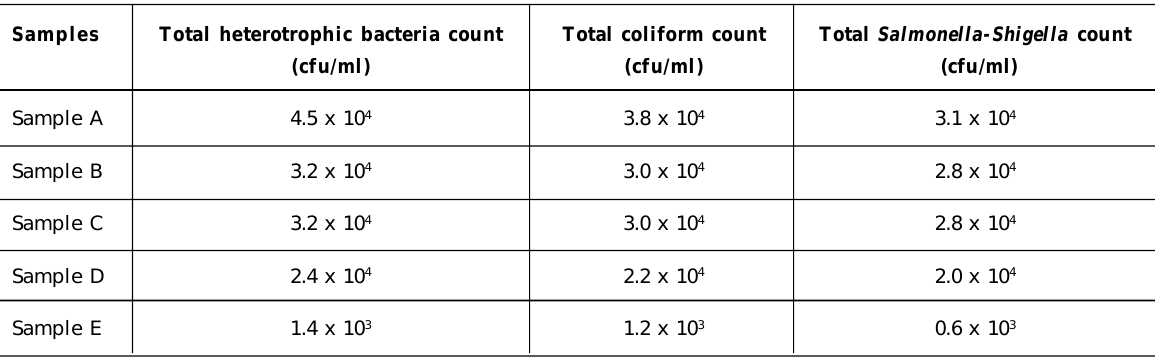
Table 1: Bacterial load of kunu samples